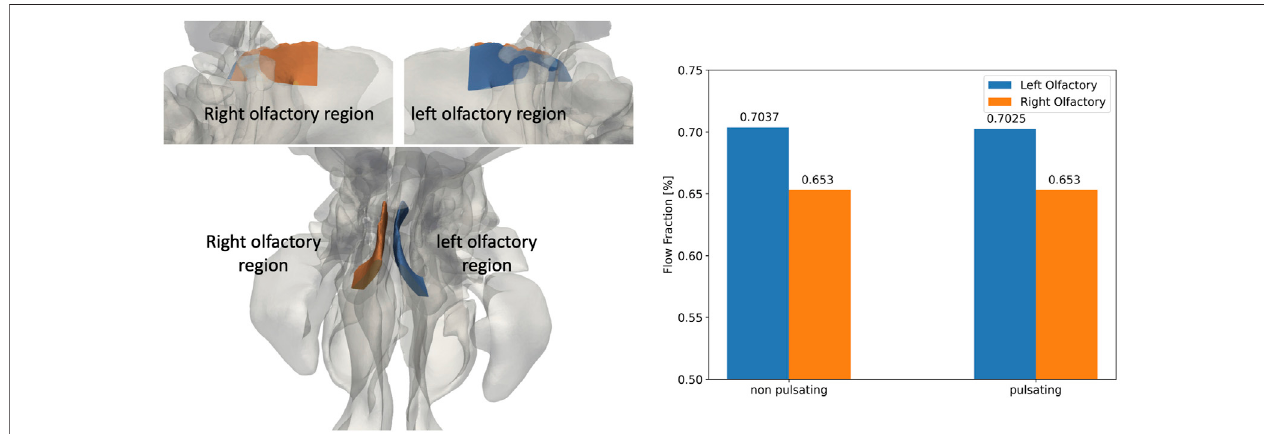
FIGURE8| Thegeometryoftheright(blue)andleft(orange)olfactoryregions(left fi gures)andthecorrespondingfractionofdrug-ladenair fl owfornon-pulsatileand pulsatile inlet air fl ow conditions (right plot) at the end of the inhalation phase ( t (cid:2) 1.98 s). The geometries of the olfactory regions are shown both from the side (top left) and the top (bottom left). The observed difference between fl ow fraction in the left and right olfactory region is due to corresponding differences in the left and right volume of the olfactory epithelium region, respectively.